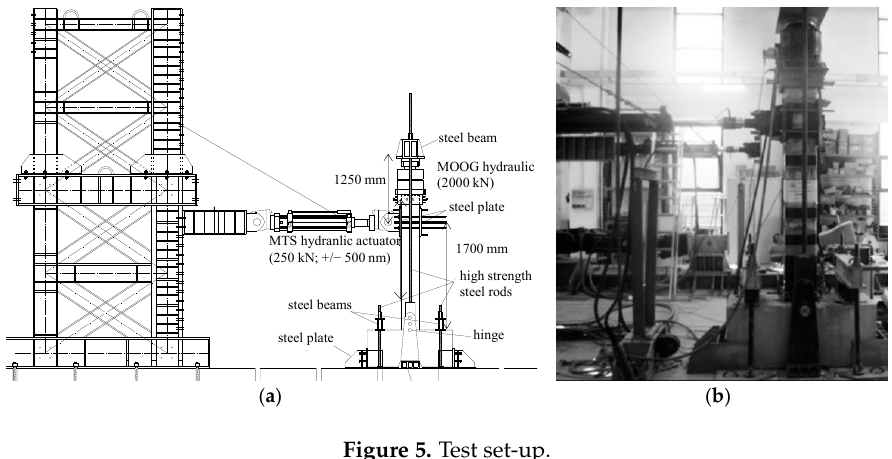
Figure 5. Test set-up.